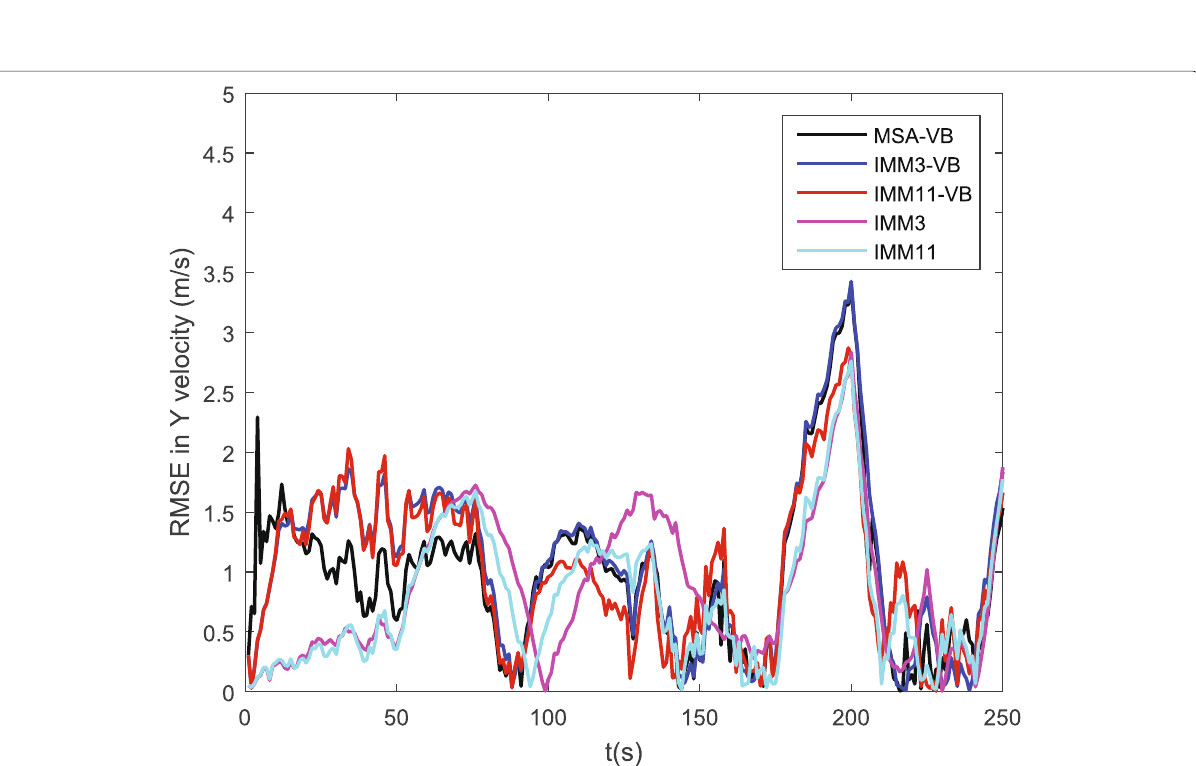
Fig. 4 RMSEs in Y Velocity of the proposed algorithm, IMM3, IMM11, IMM3-VB, and IMM11-VB in scenario